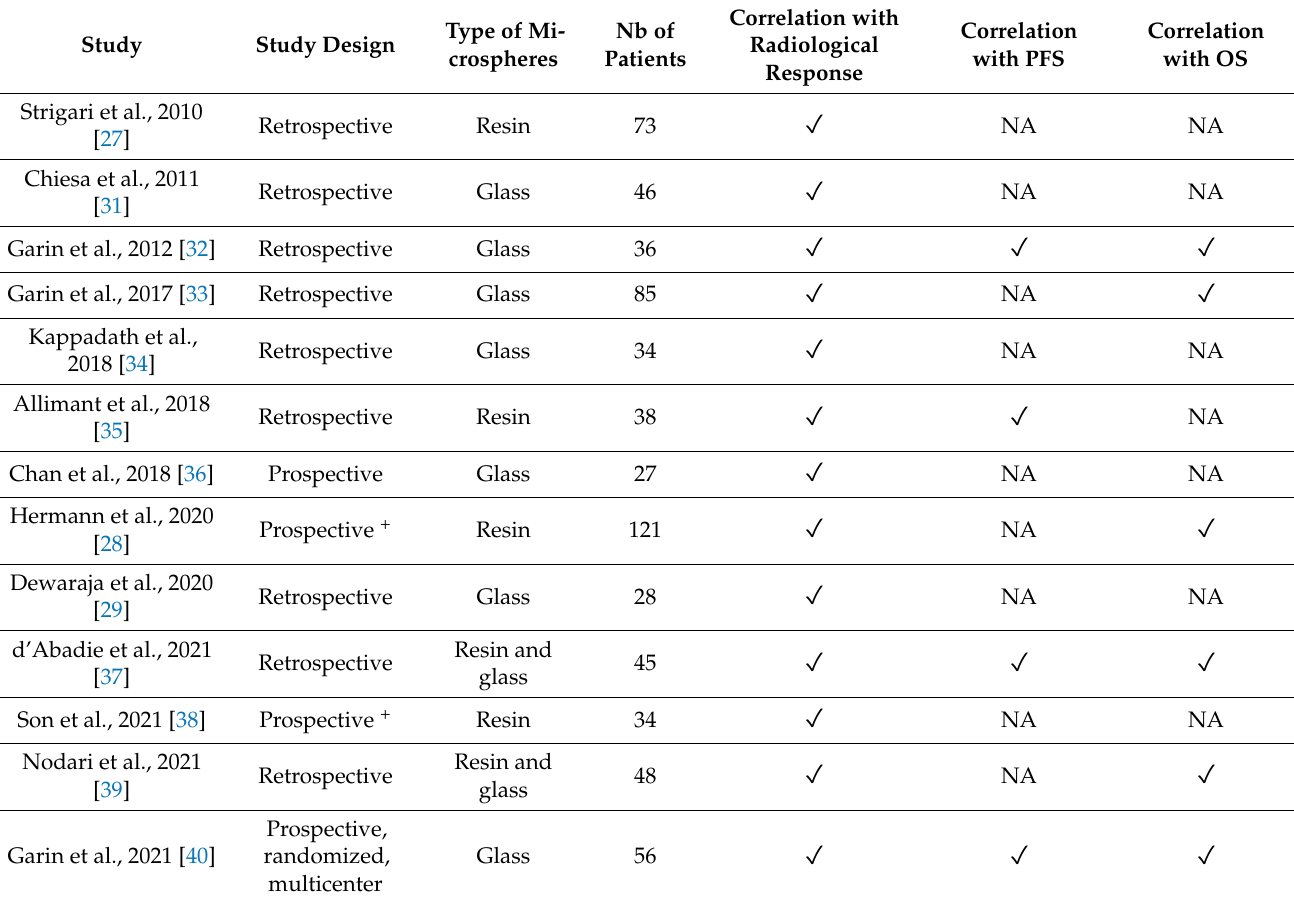
Table 3. Main studies reporting threshold absorbed doses correlated with clinical outcome in hepatocellular carcinoma using glass microspheres. Nb, Number; OS:, overall survival; PFS, progression-free survival ; ✓ , significant correlation with tumor dosimetry; NA, not available. + Secondary analysis of prospectively acquired data.